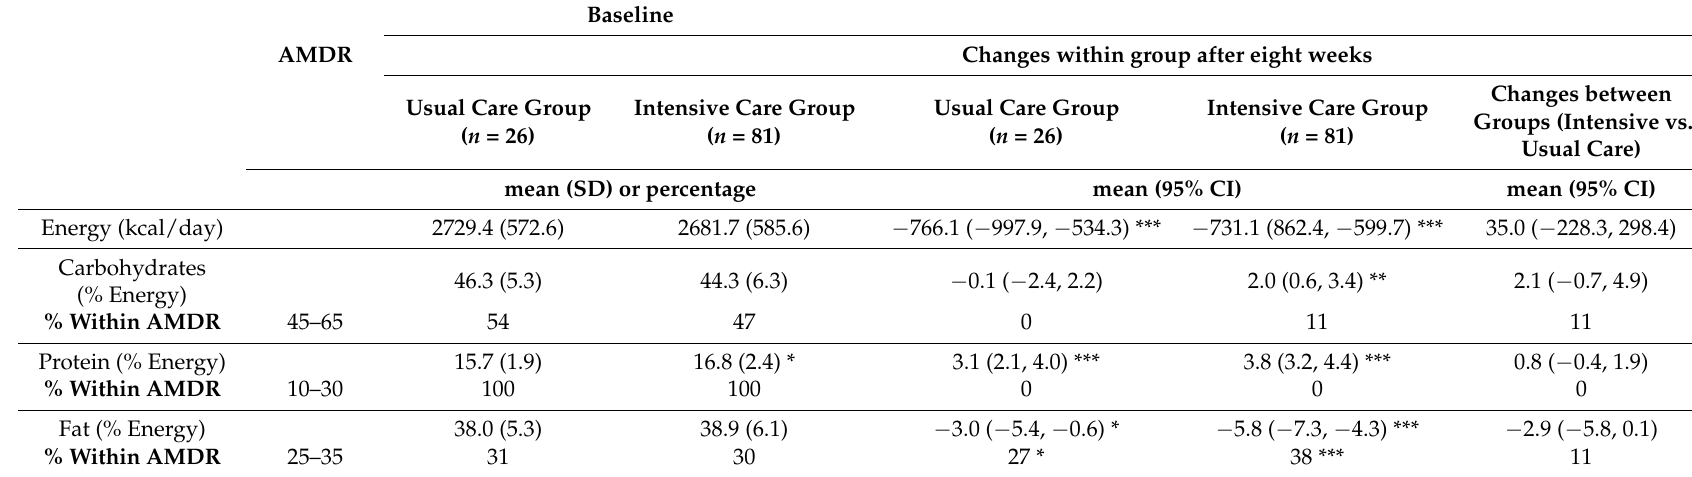
Table 3. Percentage of energy from macronutrients, and proportion (%) of individuals within the acceptable macronutrient distribution range (AMDR). Baseline AMDR Changes within group after eight weeks Changes between Usual Care Group Intensive Care Group Usual Care Group Intensive Care Group Groups (Intensive vs. ( n = 26) ( n = 81) ( n = 26) ( n = 81) Usual Care) mean (SD) or percentage mean (95%